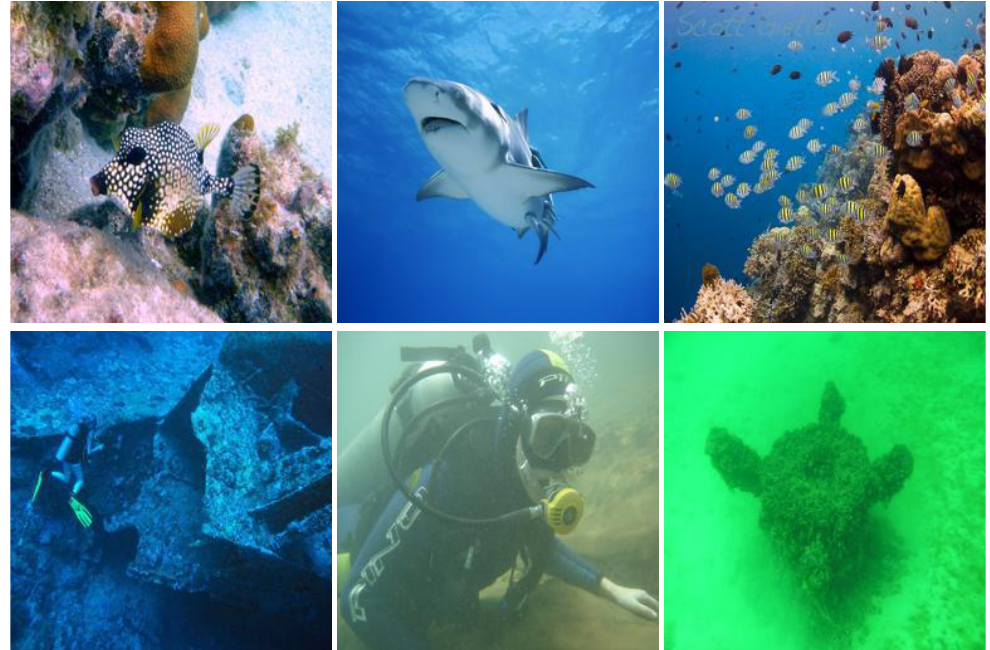
Figure 2. Samples from the training dataset. ( First row ): images in the clean domain. ( Second row ): images in the turbid